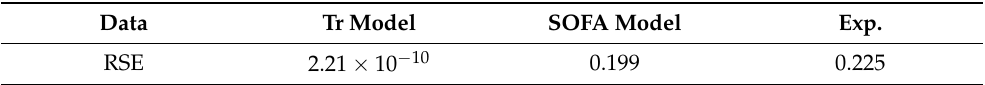
Table 9. Residual standard error (RSE) for the determination of a and b .